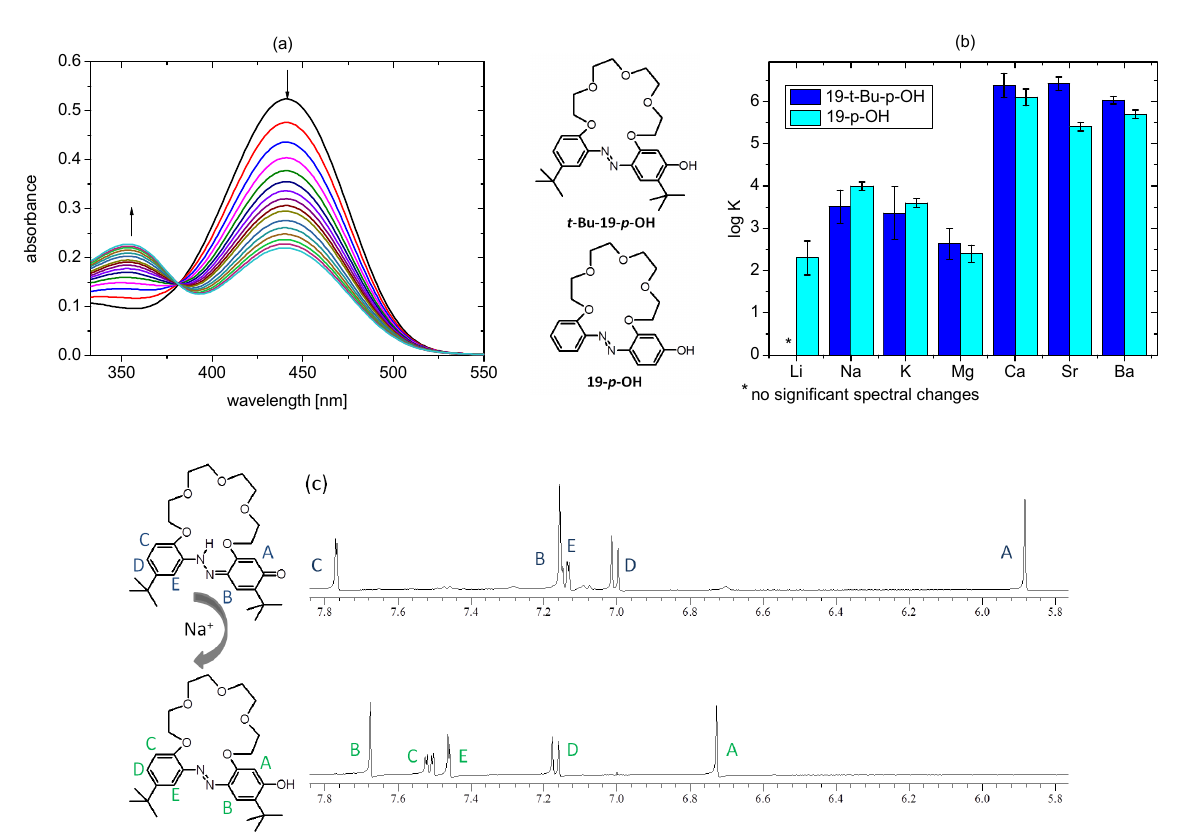
Figure 16. ( a ) Changes in UV-Vis spectrum upon titration of t -Bu-19- p -OH (1.56 × 10 − 5 M) with sodium perchlorate (0–1.6 × 10 − 3 M); ( b ) comparison of the stability constants values (log K) of 1:1 complexes of 19-membered p -hydroxyazobenzocrowns (shown here as azo–phenol tautomers): t -Bu-19- p -OH and 19- p -OH [26] in acetonitrile; ( c ) partial (aromatic proton signals range) 1 H NMR spectrum of t -Bu-19- p -OH (top; 5.7 × 10 − 3 M), registered in the presence of 10-fold excess of sodium perchlorate bottom (acetonitrile- d 3 ).